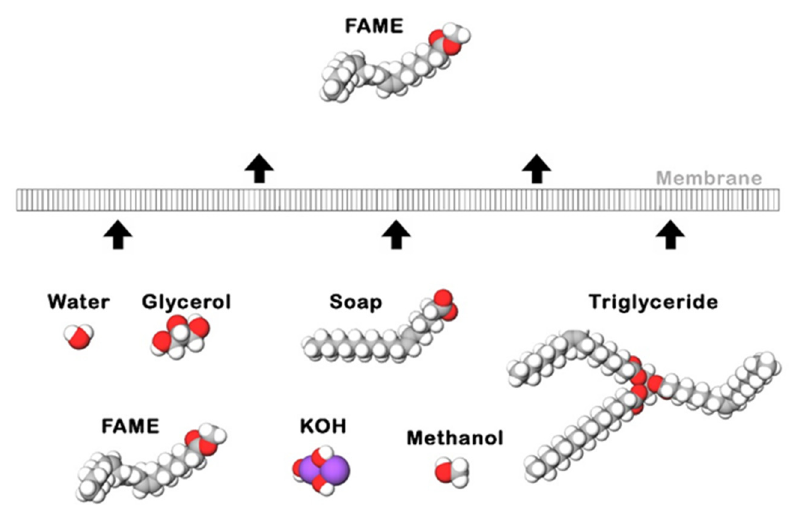
Figure 3. Biodiesel purification by membrane separation process.